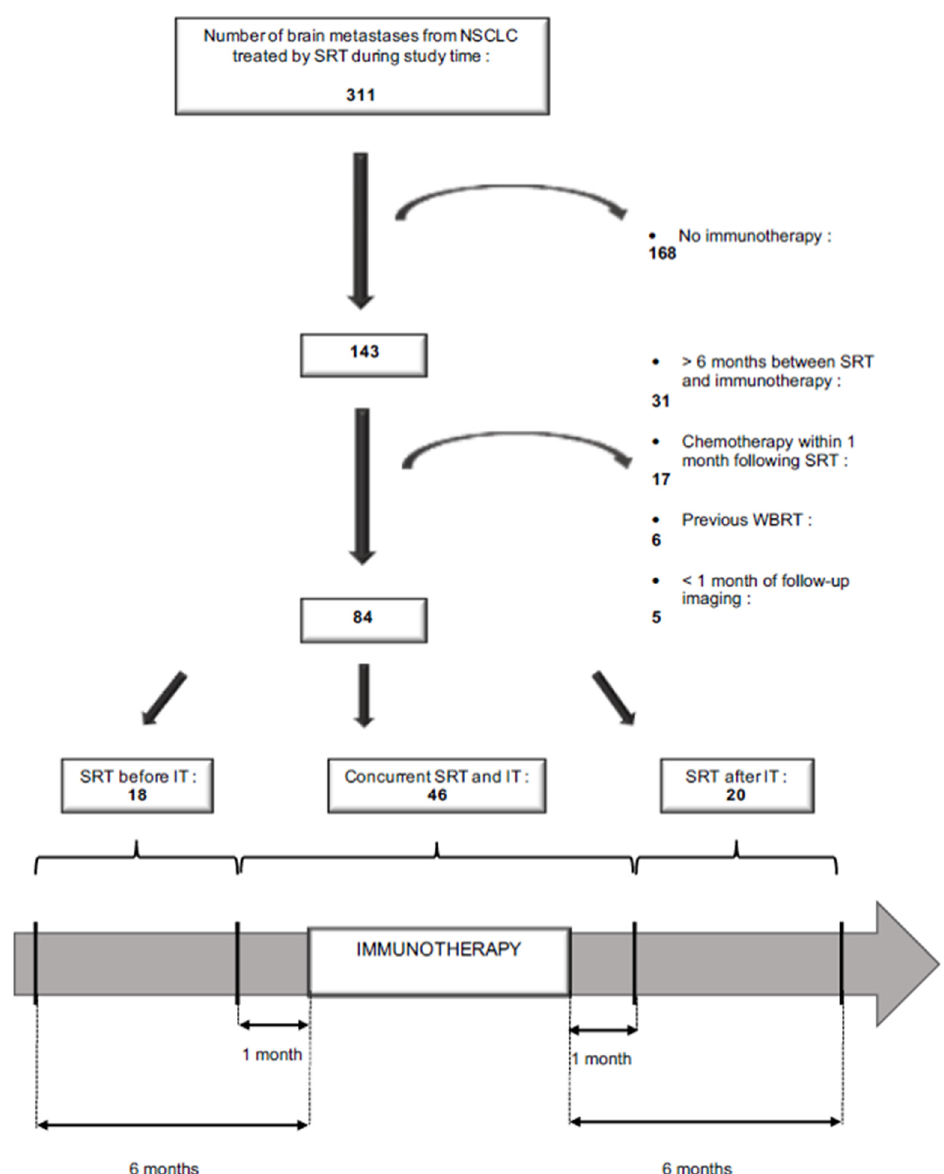
Figure 1. Flow-chart. Figure 1.